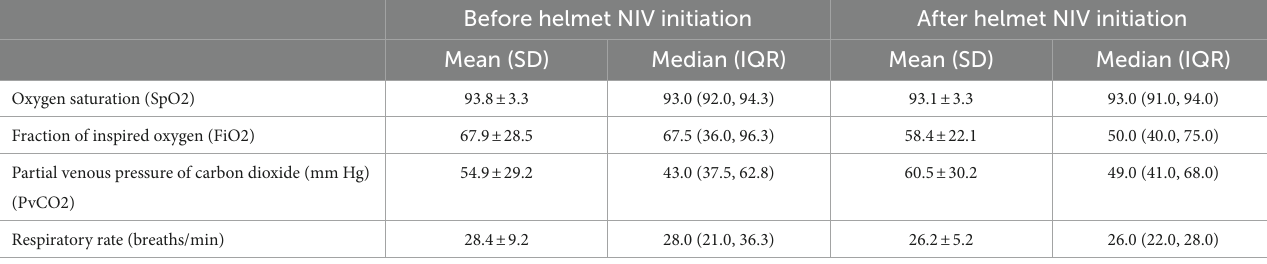
TABLE 2 Average NIV